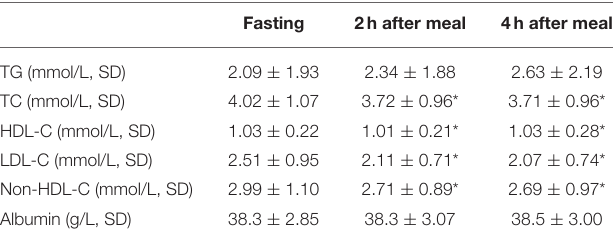
TABLE 2 | Changes in levels of blood lipids and albumin after a daily breakfast in 89 CHD patients. Fasting 2h after meal 4h after